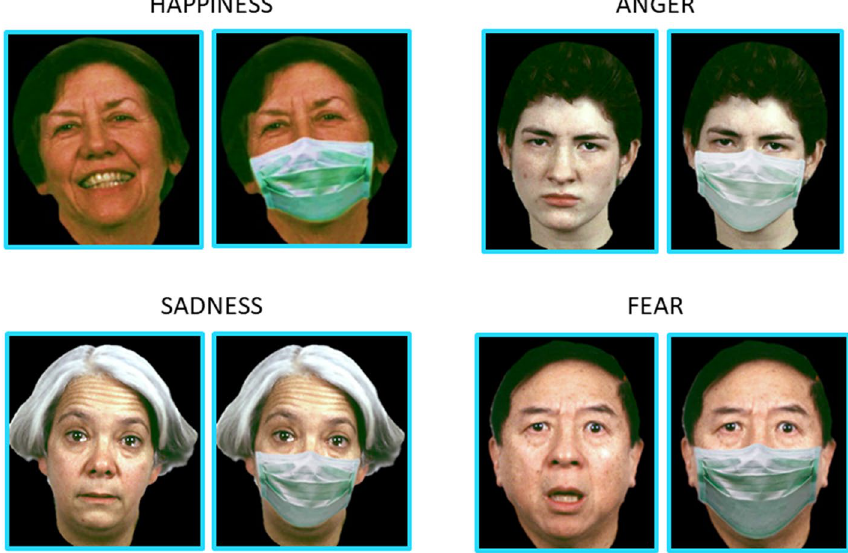
Figure 1. Examples of low-intensity facial configuration with and without face masks for happiness, anger, sadness, and fear. Face images were obtained with permission from the ER-40 colour emotional stimuli public database 29,30